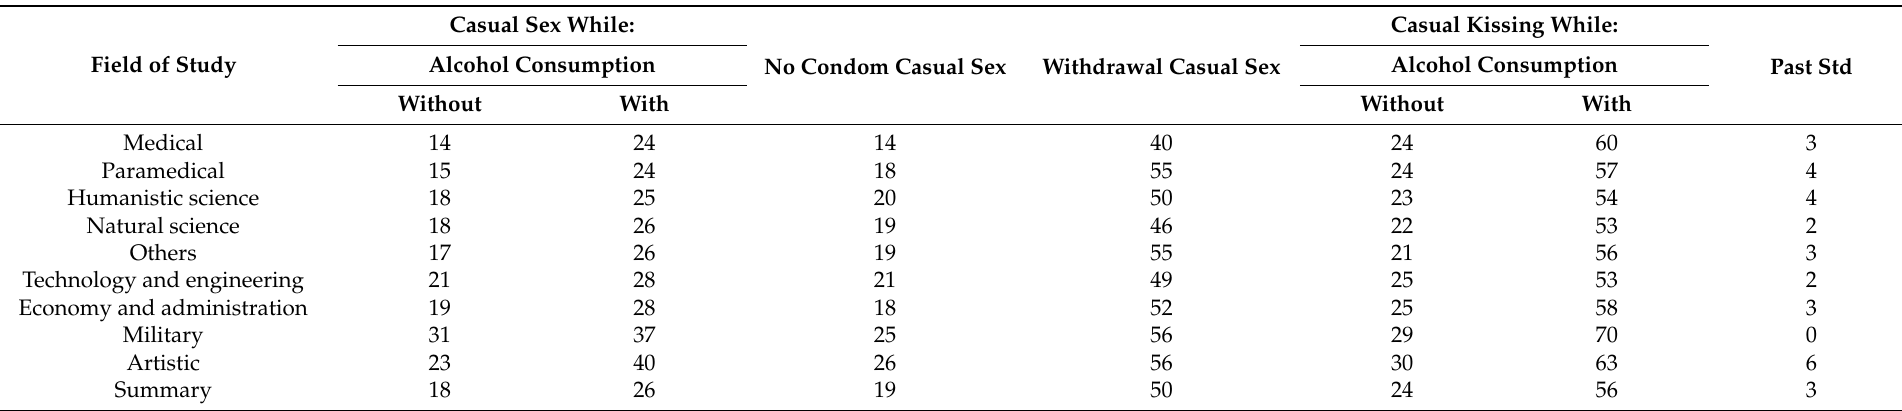
Table 5. Characterization of risky sexual behavior among different faculties. All data contained in the table are presented as a